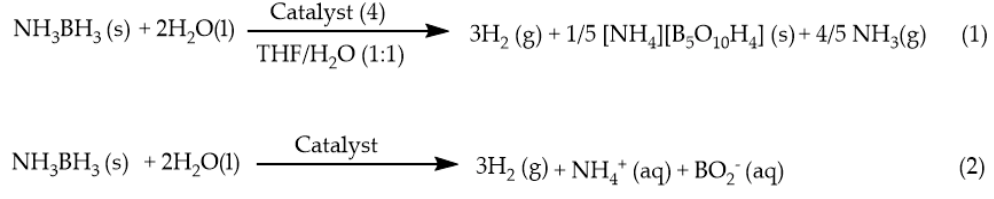
Scheme 1. Di ff erent fate of ammonia borane Scheme 1. Different fate of ammonia borane hydrolysis.